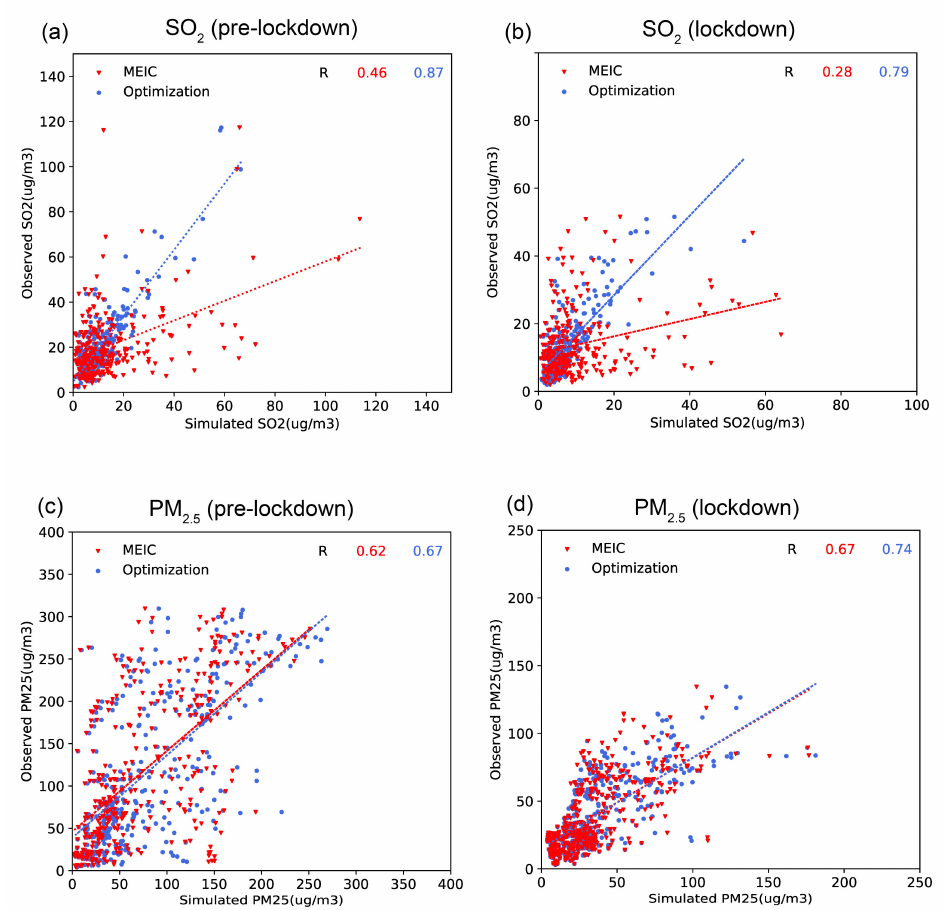
Figure 7. Scatter plots and Pearson correlation coefficients (R) of SO 2 and PM 2.5 concentrations (unit: µ g/m 3 ) between simulated and observed concentrations based on MEIC (red) and optimized (blue) inventories during the ( a , c ) pre-lockdown and ( b , d ) lockdown